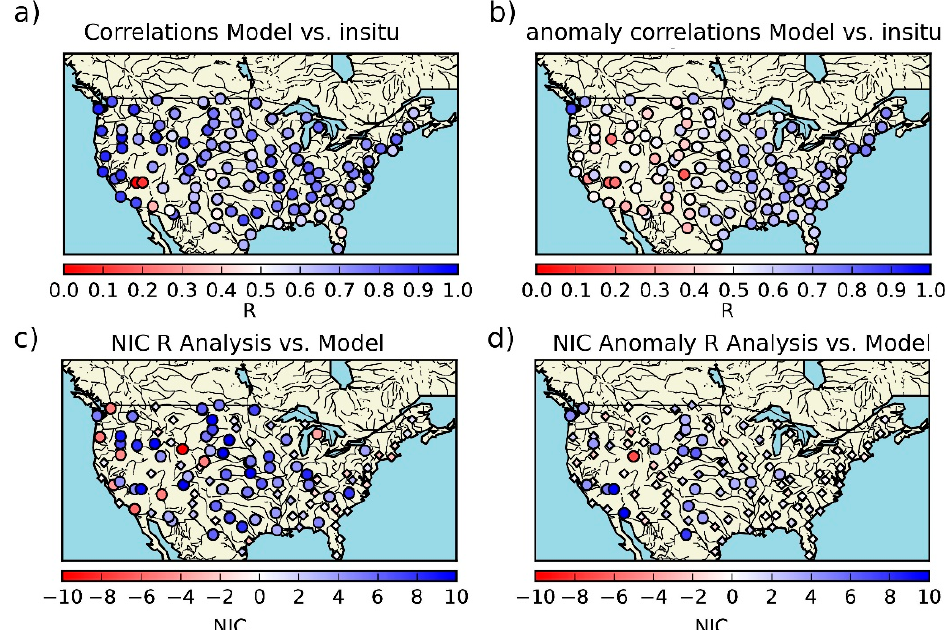
Figure 7. Maps of correlation (R) on volumetric time-series ( a ) and anomaly time-series ( b ) between in situ measurements at 5 cm depth from the US Climate Reference Network (USCRN) network and soil moisture from the model (third layer of soil between 4 cm and 10 cm) from 2010 to 2016. NIC applied on R (anomaly R) values ( c , d ); analysis with respect to the model. NIC scores are classified according to three categories: (i) negative impact from the analysis with respect to the model with values smaller than − 3% (red circles), (ii) positive impact from the analysis with respect to the model with values greater than +3% (blue circles), and (iii) neutral impact from the analysis with respect to the model with values between − 3% and 3% (diamonds).